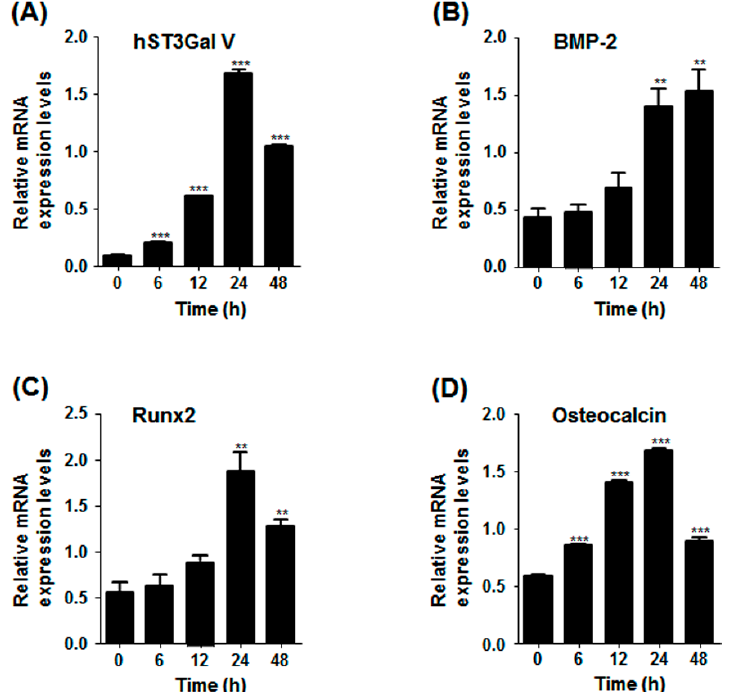
Figure 4. Quantitative real-time PCR analysis of the expression levels of osteoblastic markers and hST3Gal V in SD-induced MG-63 cells. Total RNA from MG-63 cells was isolated after incubation in serum-free medium for the indicated time periods, and mRNA transcripts of hST3Gal V ( A ) and osteoblastic markers ( B – D ) were was analyzed by quantitative real-time PCR. The transcript copy numbers of osteoblastic markers and hST3Gal V were normalized to the β -actin transcript copy number for each sample. Experiments were repeated three times to check the reproducibility of results. ** p < 0.01 (compared to the control); *** p < 0.001. As the next step, the correlation between mRNA and protein expression levels of hST3Gal V by SD was evaluated by Western blot analysis using an hST3Gal V-specific monoclonal antibody. As shown in Figure 3C, protein levels of hST3Gal V were also increased in a time-dependent manner.